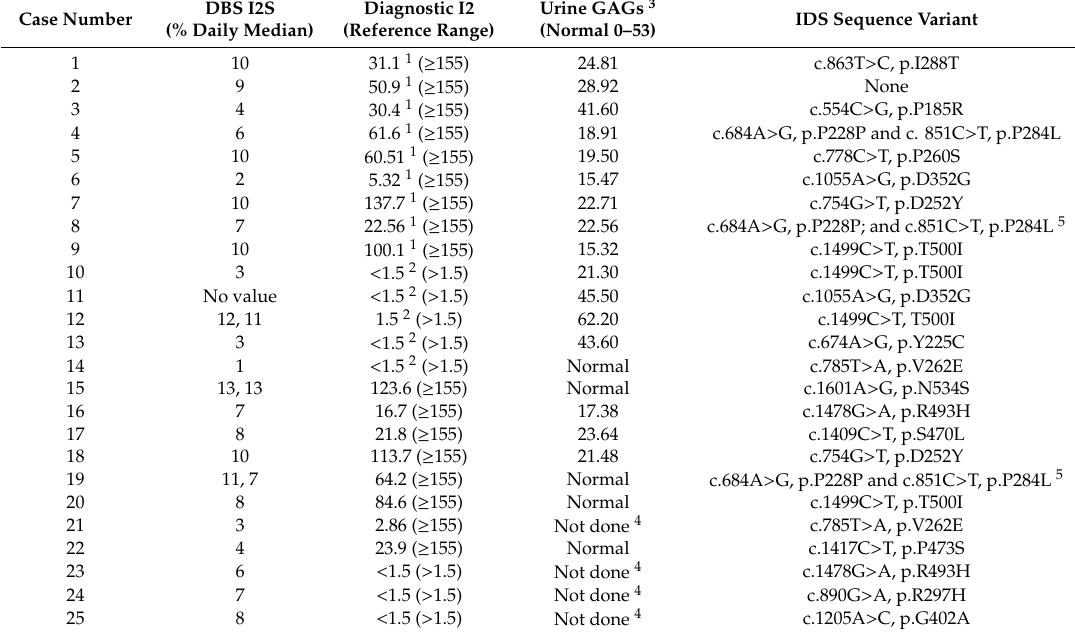
Table 1. Results of follow-up testing in infants with iduronate-2-sulfatase (I2S) pseudodeficiency. Case